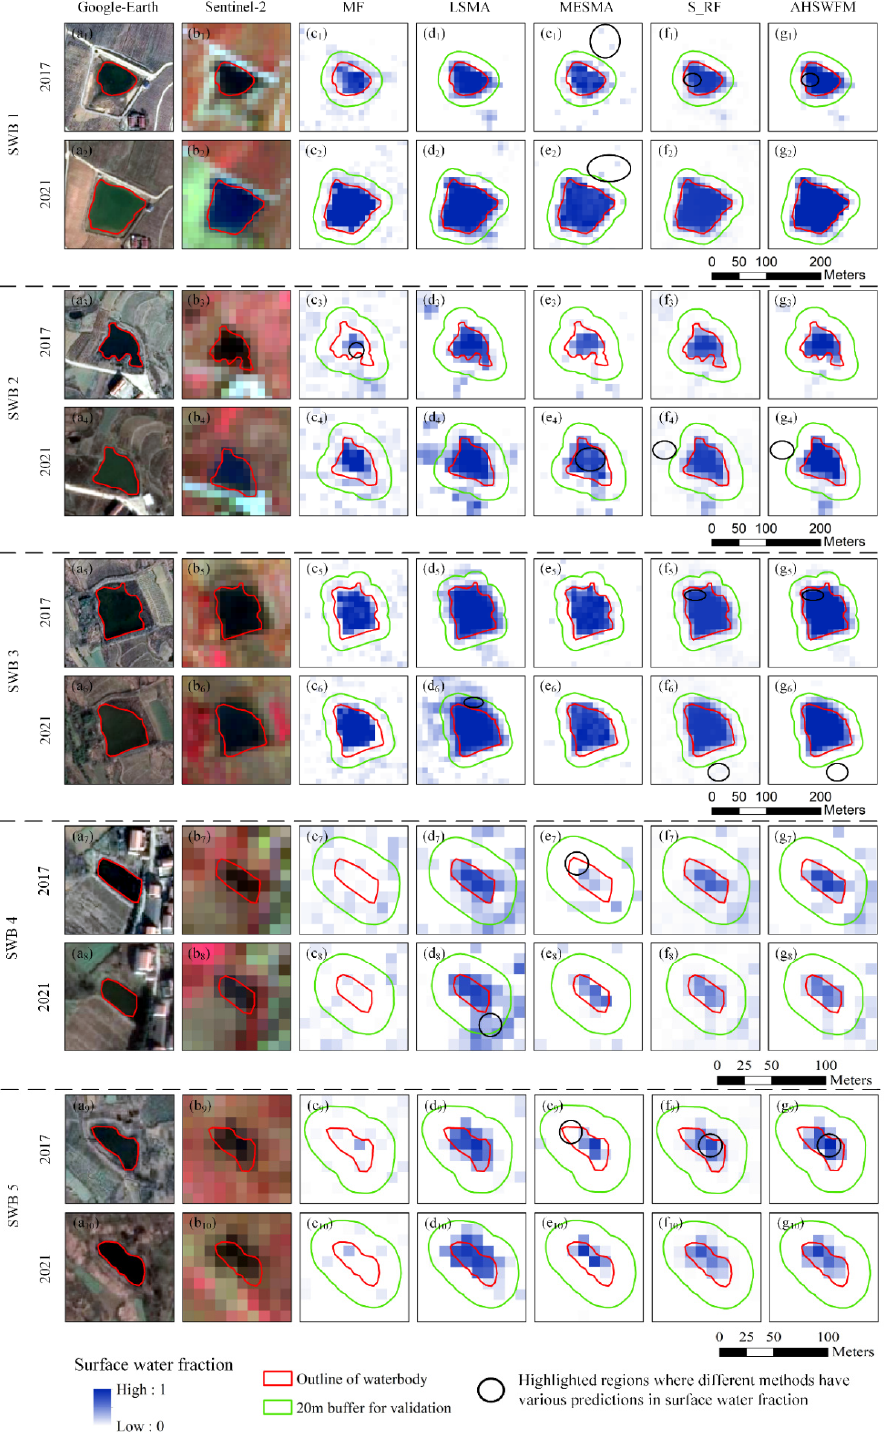
Figure 8. Zoomed-in areas of Google Earth and Sentinel-2 images and predicted water fraction maps obtained from the five methods highlighted in red rectangles in Figure 6 ( a 1 – a 10 ) Google Earth images, ( b 1 – b 10 ) Sentinel-2 images, ( c 1 – c 10 ) matched filtering (MF), ( d 1 – d 10 ) linear spectral mixture analysis (LSMA), ( e 1 – e 10 ) multiple endmember spectral mixture analysis (MESMA), ( f 1 – f 10 ) self-trained random forest regression (S_RF) and ( g 1 – g 10 ) automatic and hierarchical surface water fraction mapping (AHSWFM). S_RF and AHSWFM with a window size of 10 and a fixed window shift in the aggregation to coarse pixel samples in the water fraction regression were